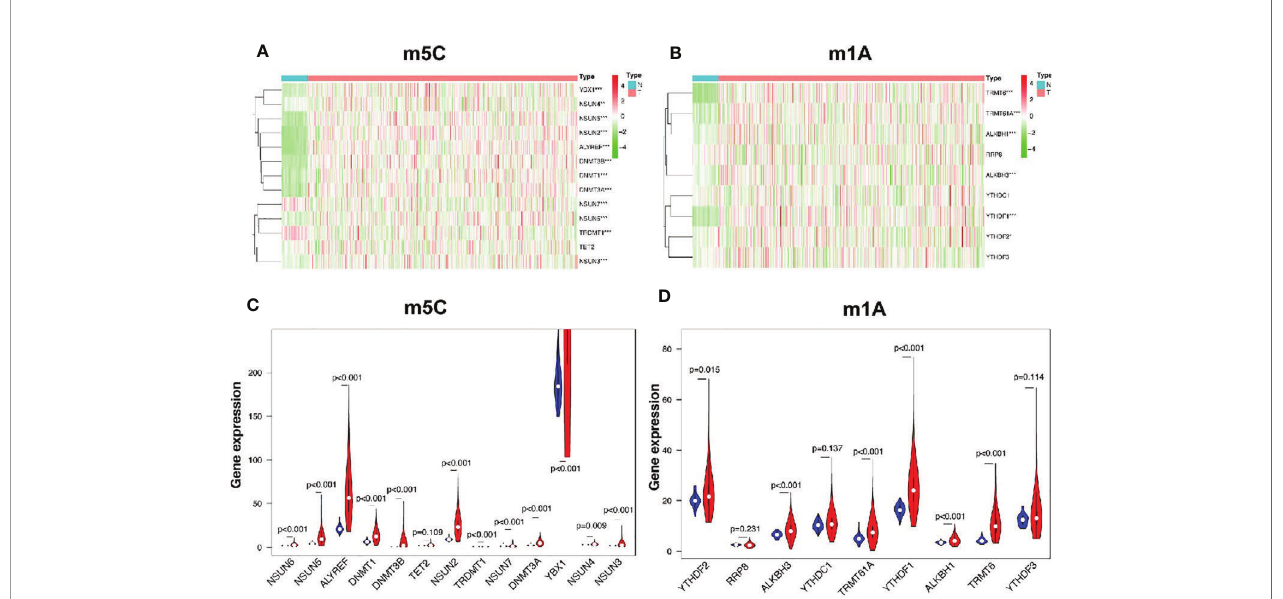
FIGURE 1 | Identi fi cation of differential genes between m5C and m1A regulators in LUSC and normal groups. (A, C) The heatmap and violin plot visually show the expression differences in m5C regulators between the two groups. (In the tumor group, the expression interval of YBX1 was large, and only partial data were intercepted.) (B, D) The heatmap and violin plot visually show the expression differences in m1A regulators between the two groups. N, normal samples; T, tumor samples; blue violins represent normal samples; red violins represent tumor samples; * p < 0.05, ** p < 0.01, *** p <